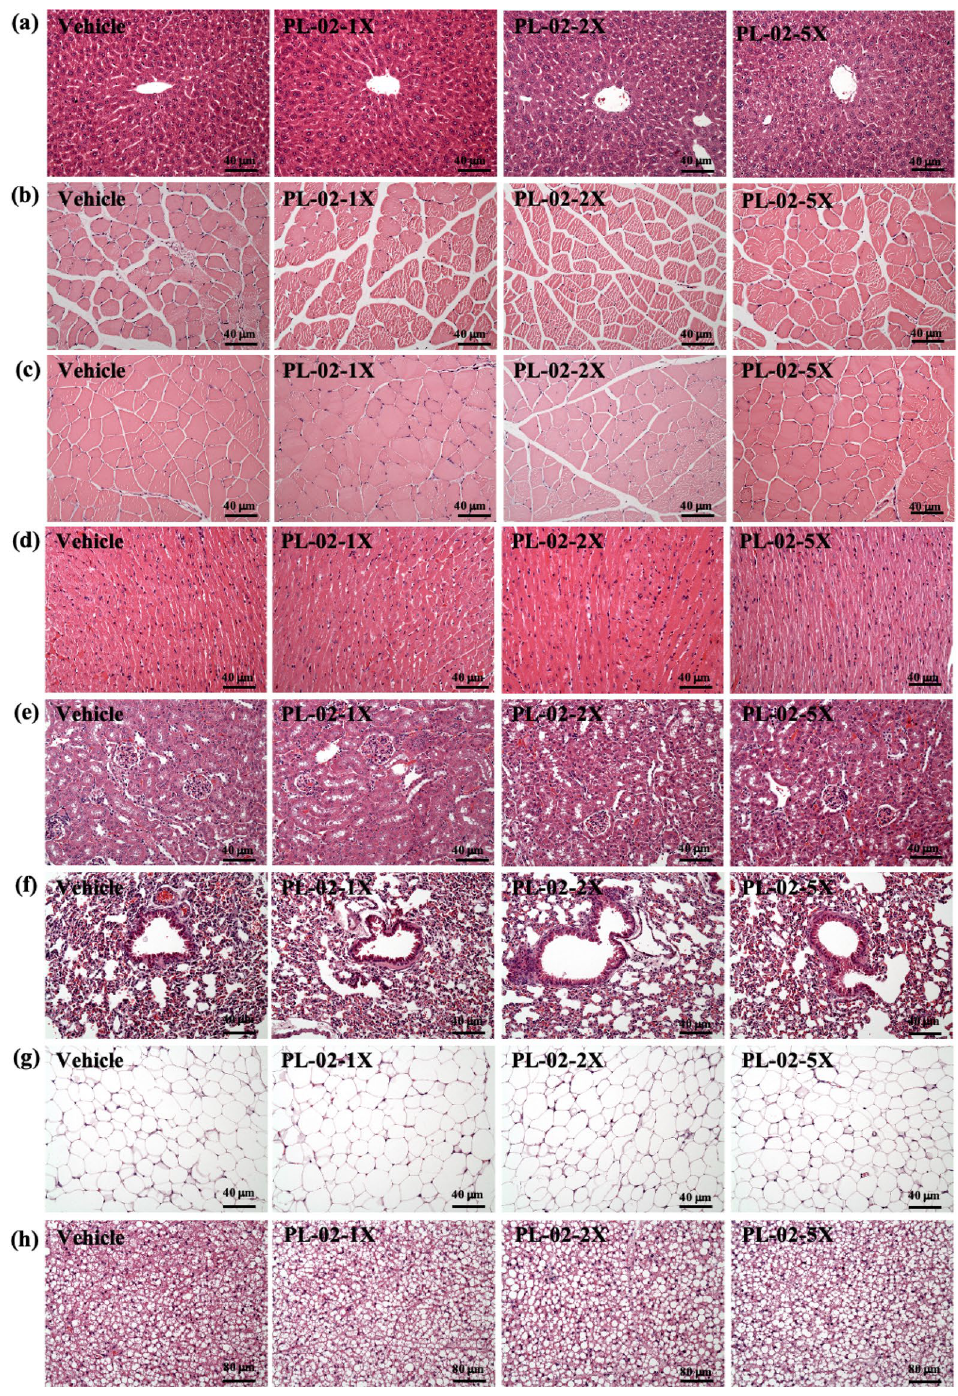
Figure 4. Effect of PL-02 supplementation on ( a ) liver, ( b ) muscle, ( c ) quadricep muscles, ( d ) heart, ( e ) kidney, ( f ) lung, ( g ) adipocyte tissue, and ( h ) BAT tissue in mice. (H&E stain, magnification: × 200; bar, 40 μm; BAT magnification: 100 × ; bar, 80